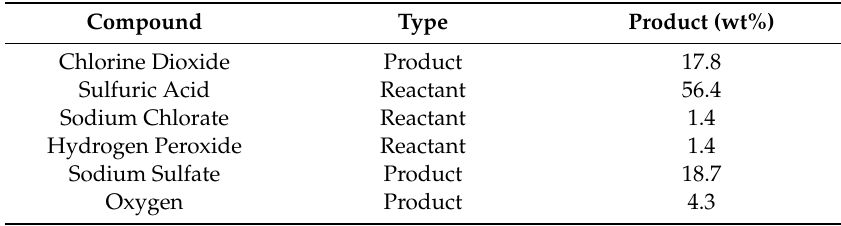
NA = generally not present. Table 17. Product composition for a commercial chlorine dioxide product generated using sodium chlorate via Equation (28) [311]; does not include side reaction or decomposition compounds.